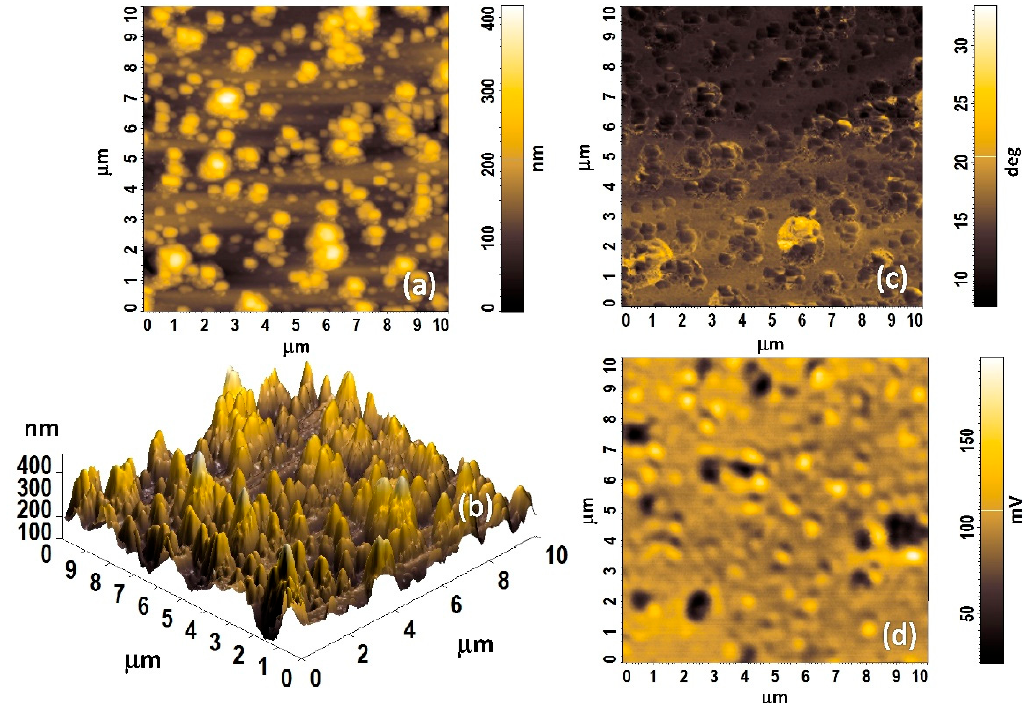
Figure 6. A top view AFM and CLSM images (area of 10 × 10 µm in the middle core of the fiber optic—red contour from Figure 5) of the Nafion ® -based fiber optic sensing microstructure with 530 nm thickness. ( a , b ) 2D and 3D topographical images, respectively; ( c ) 2D AFM phase contrast image; ( d ) 2D CLSM image.